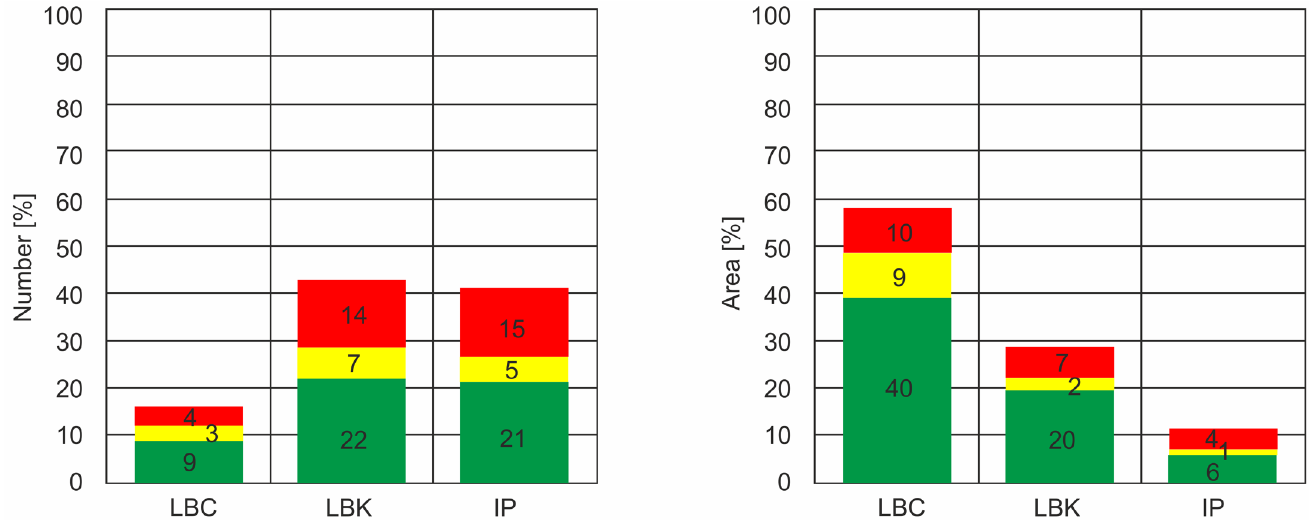
Figure 4: Proportions of existing (green), partly existing (yellow) and non-existent (red) local bio-corridors (LBK), local bio-centres (LBC) and interaction elements (IP) expressed in terms of numbers (left) and size (right)